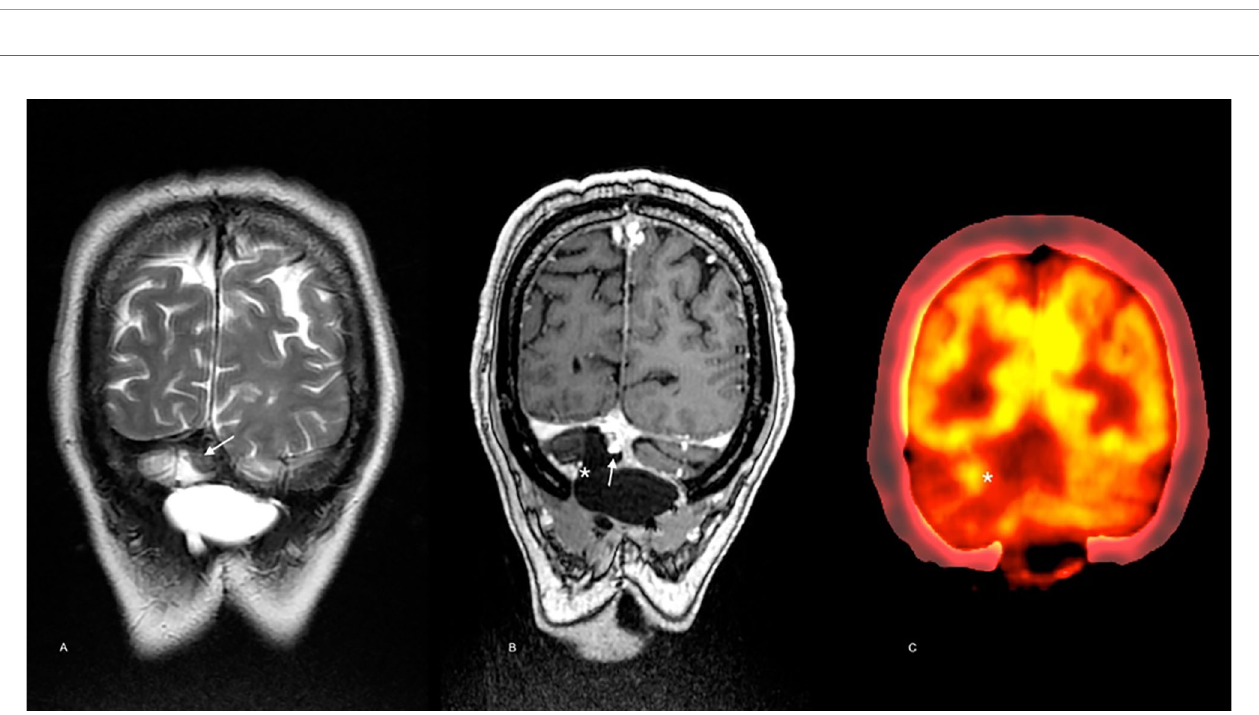
FIGURE 3 | Summary of genomic pro fi les of four different samples from the case. Samples correspond to the meningeal melanoma at diagnosis and its three further recurrences with their chromosomal alterations. The recurrence of CNAs across the samples in segmented data (y-axis) is plotted for each probe (4) evenly aligned along the x-axis in chromosomal order. The percentage of samples harboring gains, ampli fi cations, losses, and deletions for each locus is depicted according to the following scheme: dark red (gains with a log 2 ratio >=0.15) and green (loss with a log 2 ratio <= − 0.15) and are plotted along with bright red (ampli fi cations with a log 2 ratio ≥ 0.4) and bright green (deletions with log 2 ratio